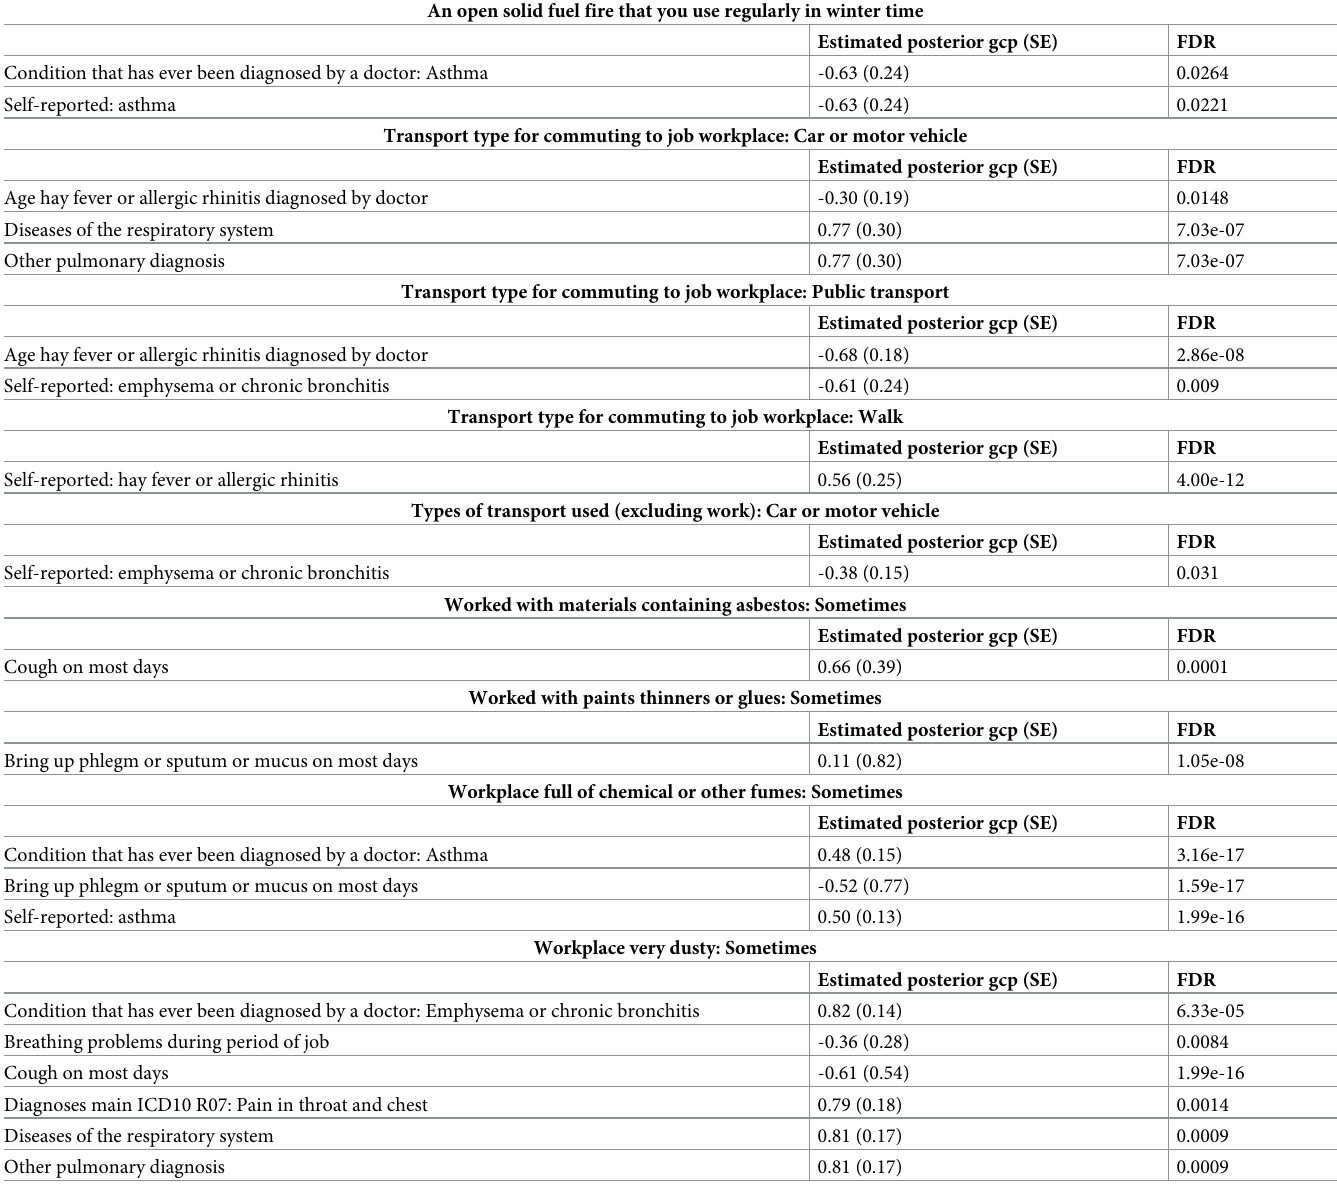
Table 1. 20 significant causal relationships between air pollutants and respiratory